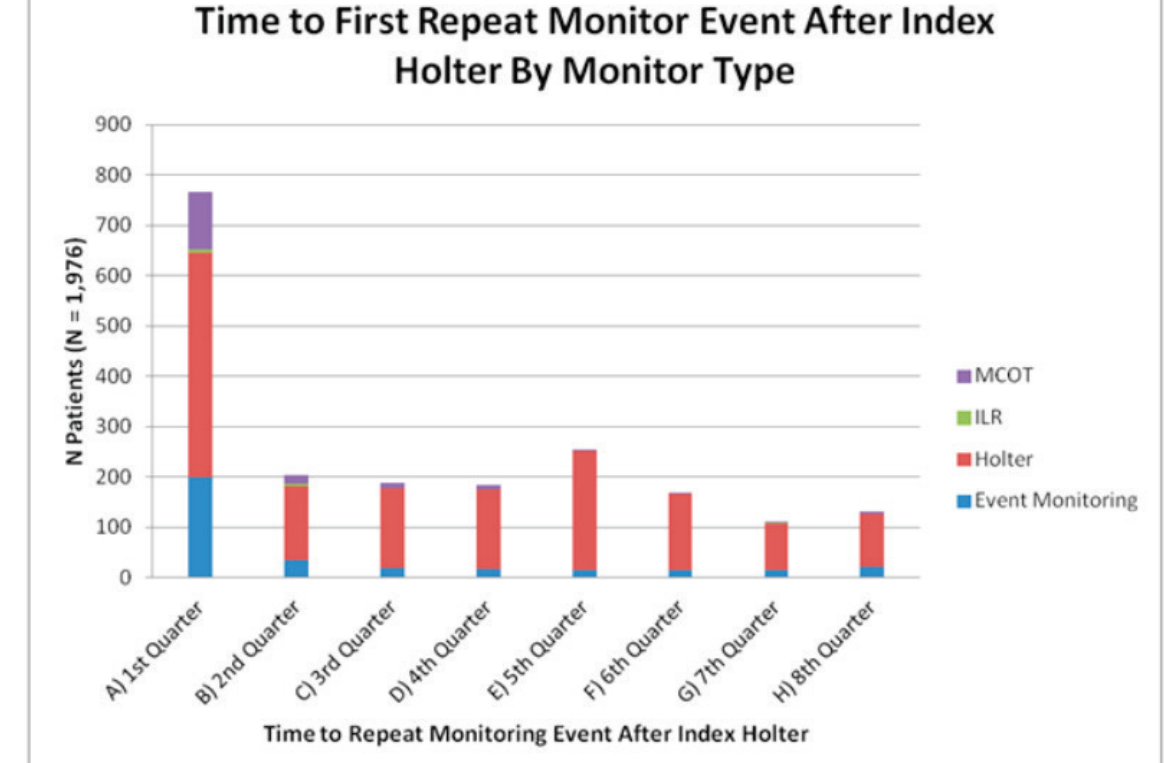
Figure 3. Time to First Repeat Monitor Event after Index Holter by Monitor Type-Group